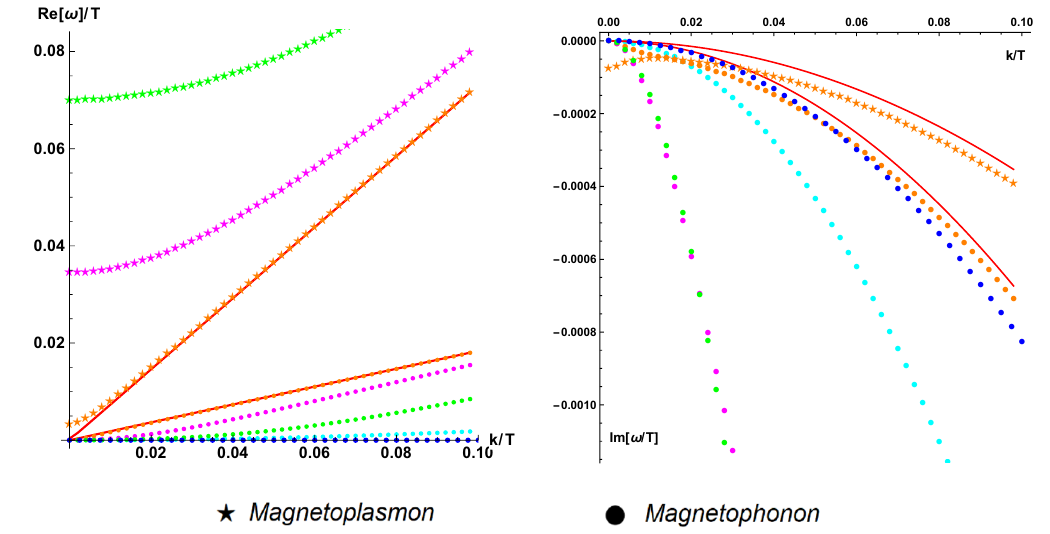
Figure 10 . The fate of the two propagating hydrodynamic sound modes under increasing the magnetic (cid:12)eld. The red lines show the results at B = 0 and the two linear sound modes. We (cid:12)x (cid:22)=T = 1 and m=T = 1 moving B=T 2 = 0.01 (orange), 0.1 (pink), 1 (green), 2 (cyan) and 4 (blue). The circles indicate the magnetophonon mode while the stars the magnetoplasmon mode. For simplicity we do not show the behavior of the di(cid:11)usive modes. Left: The real part of the dispersion relations. Cyan and blue stars are not shown as the gap becomes very large. Right: The imaginary part. The rest of the magnetoplasmons data (corresponding to green, cyan and blue stars) are not shown since the damping becomes very